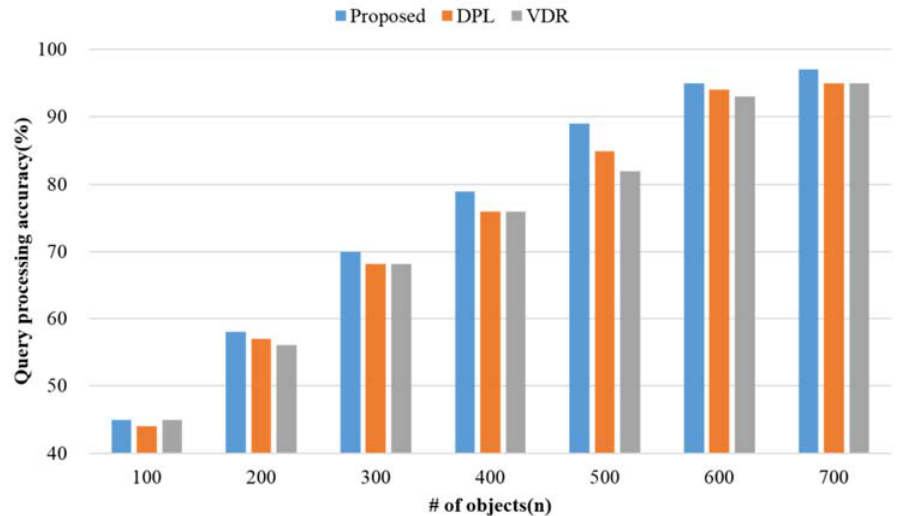
Figure 12. Query-processing accuracy according to the number of objects. Figure 12. Query ‐ processing accuracy according to the number of objects.